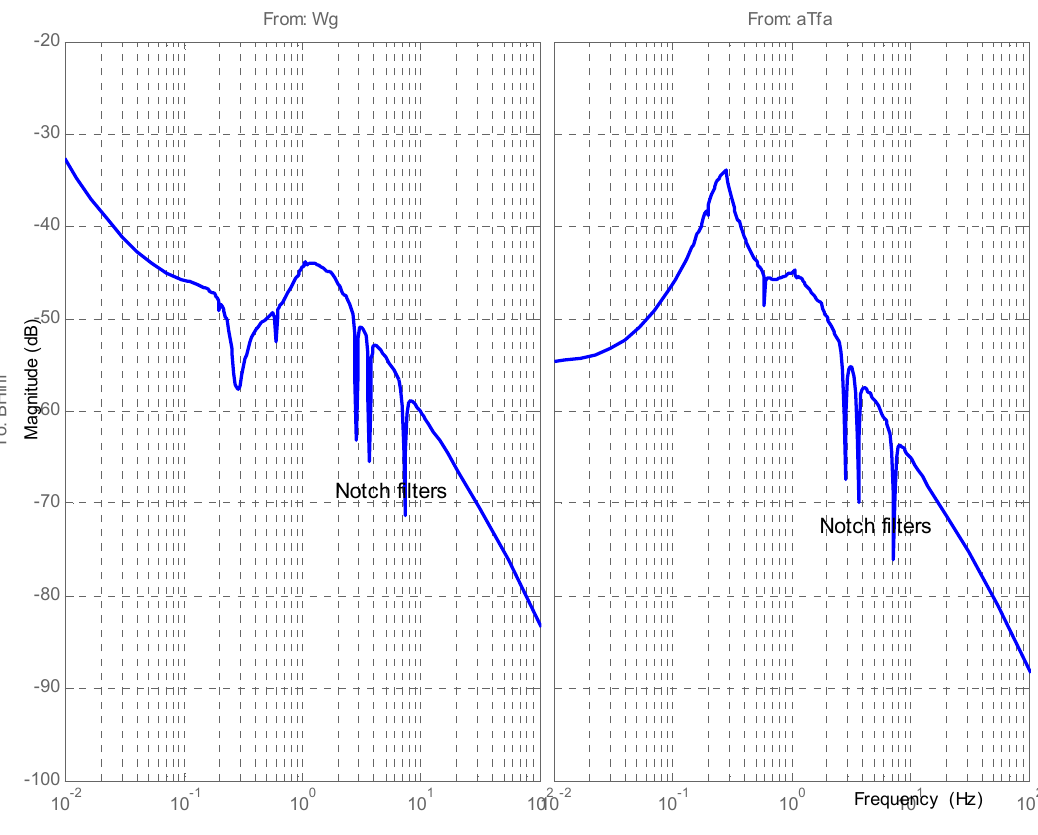
Pitch Controller. ∞